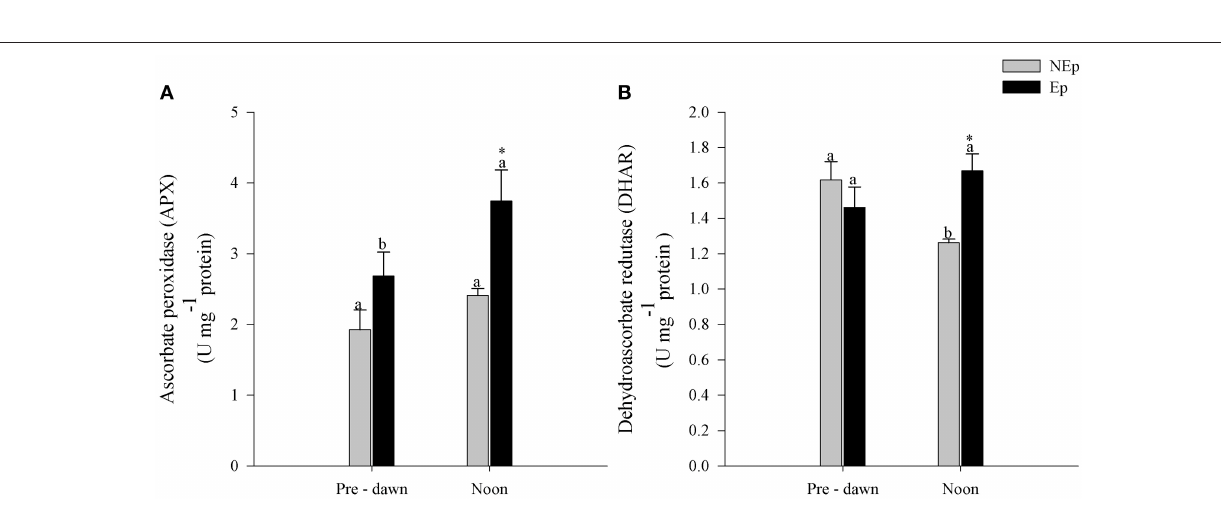
FIGURE 4 | Ascorbate peroxidase (APX) activity (A) and dehydroascorbate (DHAR) activity (B) in Posidonia oceanica leaves with (Ep) and without (NEp) epiphytes, at pre-dawn and noon. Different letters indicate significant differences between pre-dawn and noon; * indicates significant differences between Ep and NEp leaves ( n = 5 , p < 0.05